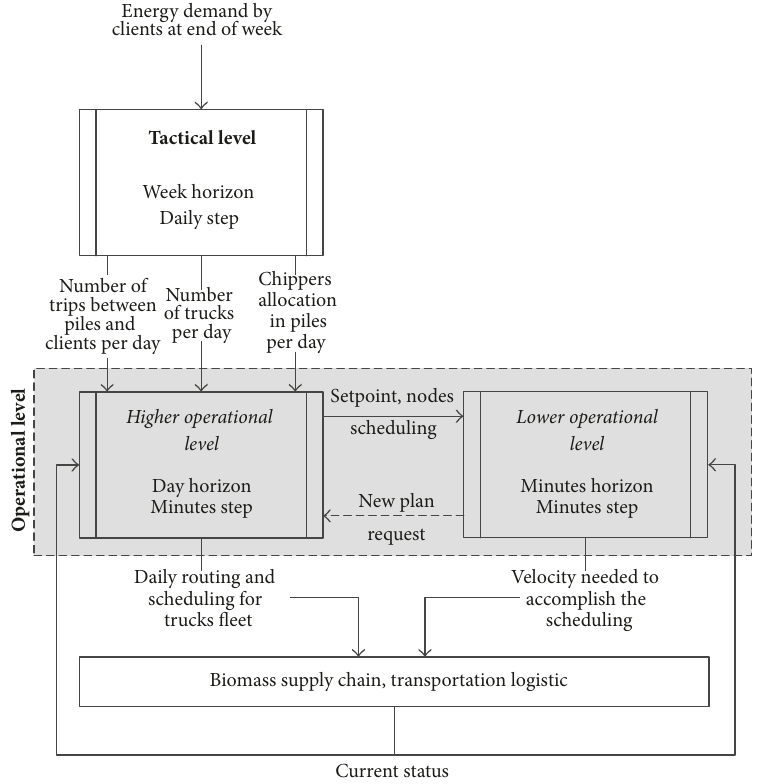
Figure 1: Multilayer operational level proposed